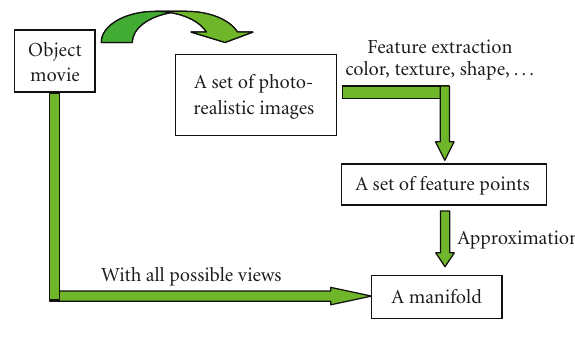
Figure 3: Representation of an object